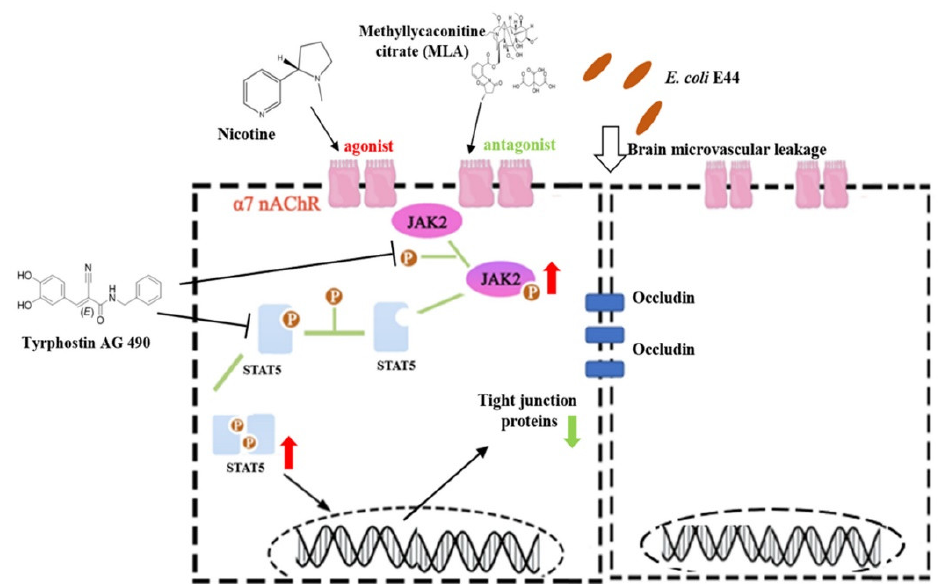
Figure 7. A systematic scheme of both α7nAChR/CISH/JAK2/STAT5 signaling pathways and inhibitors (AG490, MLA, and MEM) in the regulation of the pathogenesis of BBB disruptions.